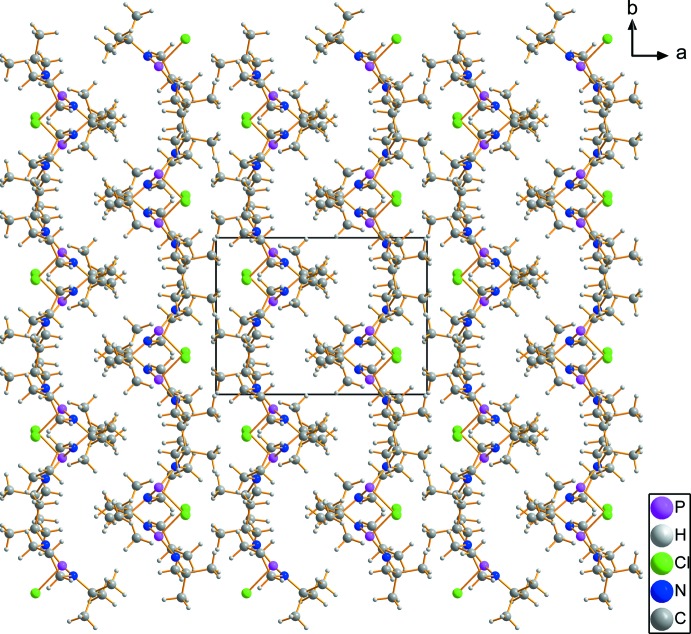
Packing diagram of 1 (view direction [00]) showing a wave-like pattern. Inspection of the inter­molecular distances gives no evidence for inter­actions stronger than van der Waals forces and inter­molecular influence on the P—Cl bonding can be excluded.